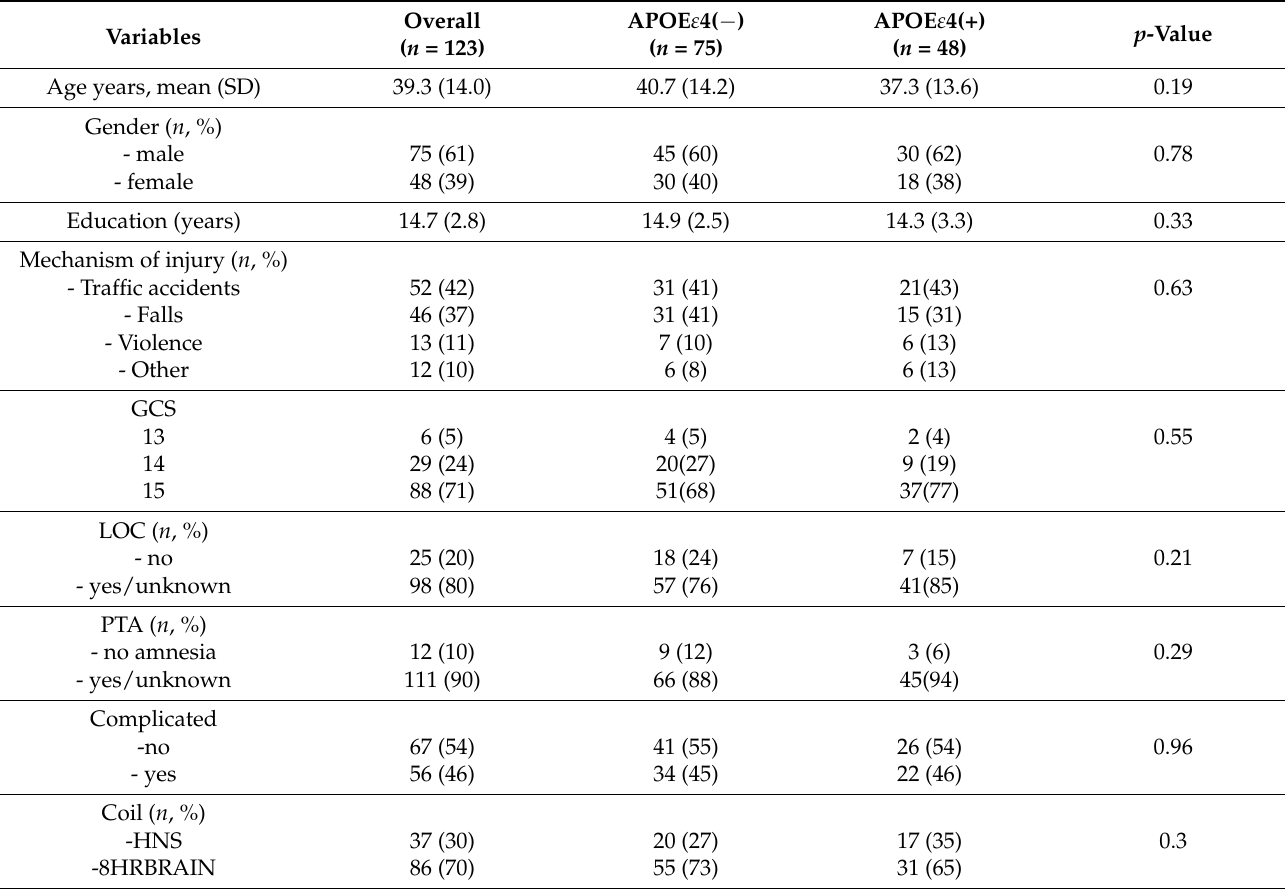
Table 1. Demographics and injury related variables of apolipoprotein E (APOE) ε 4 +/ − mild traumatic brain injuries (MTBIs) n = 123.